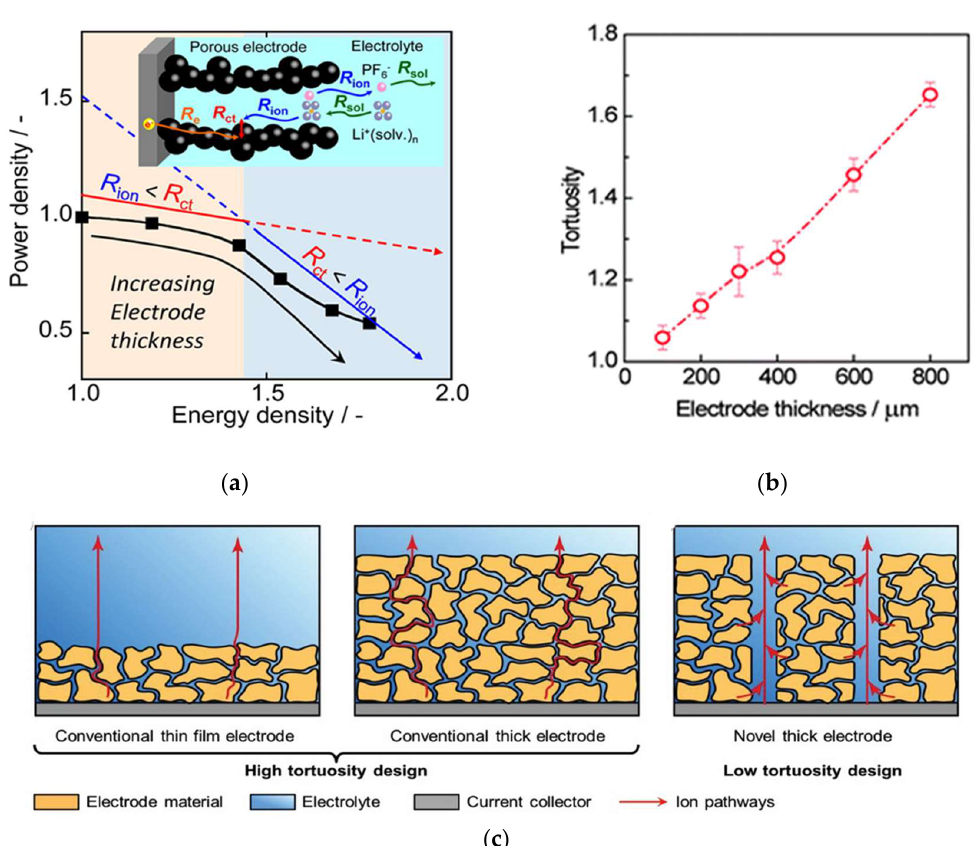
Figure 7. ( a ) The changes of R ion and R ct and their magnitude show opposite trends with respect to electrode thickness [74]. ( b ) Higher tortuosity is present in a thicker electrode [78]. ( c ) Illustration about the value of the low−tortuosity design for thick electrodes [13].